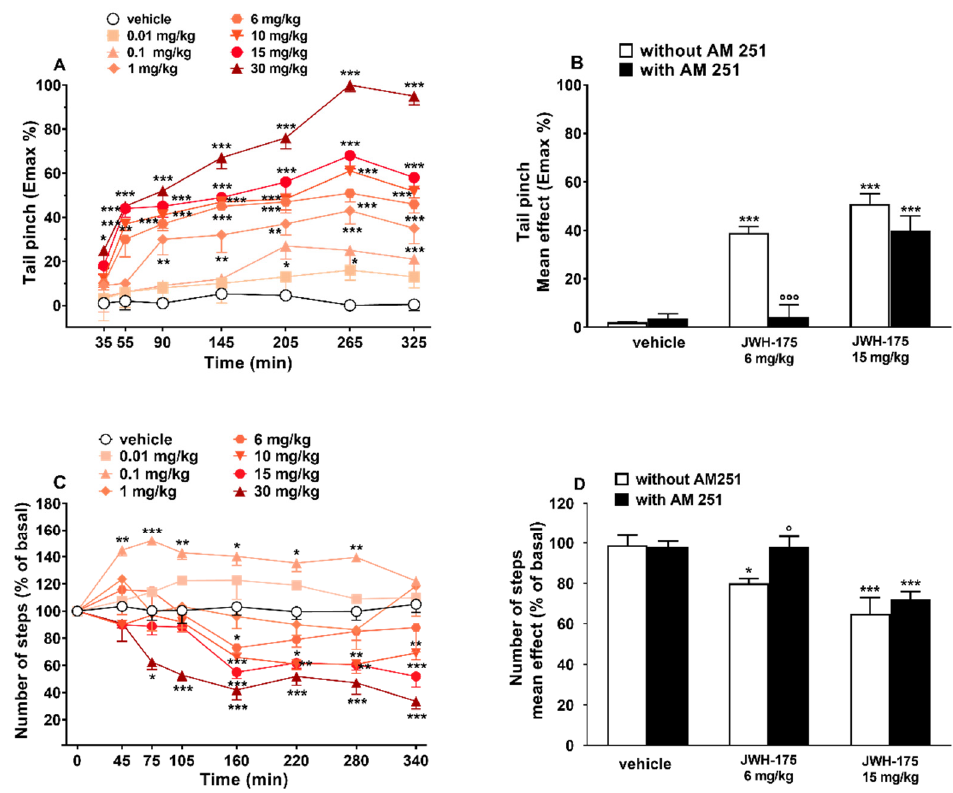
Figure 6. Effect of JWH-175 (0.01–30 mg/kg i.p.) on the tail pinch test ( A ) and drag test ( C ) in mice. Interactions of JWH-175 with the selective CB1 receptor antagonist AM-251 (6 mg/kg i.p.) are reported in histograms ( B , D ). Data are expressed as percent of maximum effect (Emax %; tail pinch test) and as percent of baseline (drag test) and represent the mean ± SEM of 8 animals for each treatment. Statistical analysis was performed by two-way ANOVA followed by Bonferroni’s test ( A , C ) for multiple comparison for the dose–response curve of each compound at different time-points. The analysis of the mean overall effect of each compound and AM-251 ( B , D ) was performed with one-way ANOVA followed by Tukey’s test. * p < 0.05, ** p < 0.01, *** p < 0.001 versus vehicle; ° p < 0.05, °°° p < 0.001 versus JWH-175.